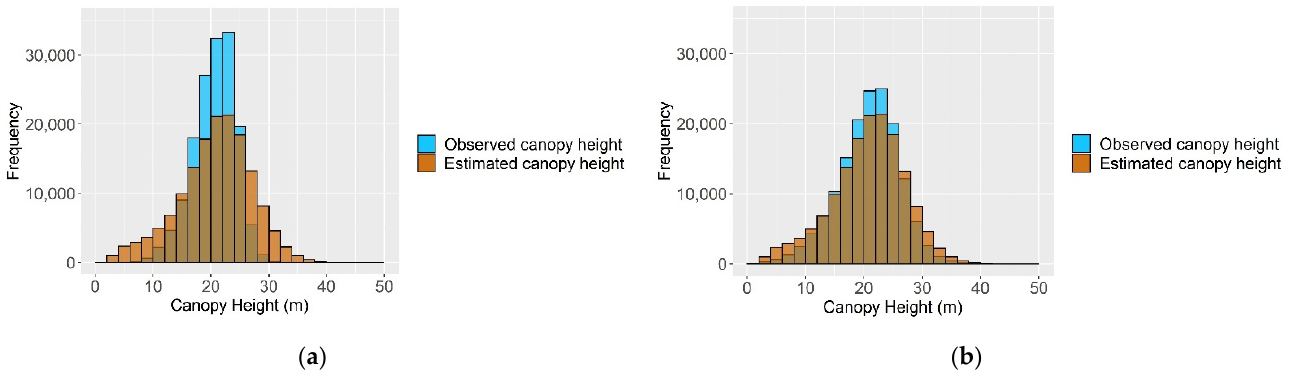
Figure 5. Histogram of observed and estimated canopy height at 30 m spatial resolution from the independent validation for ( a ) random forest and ( b ) regression kriging